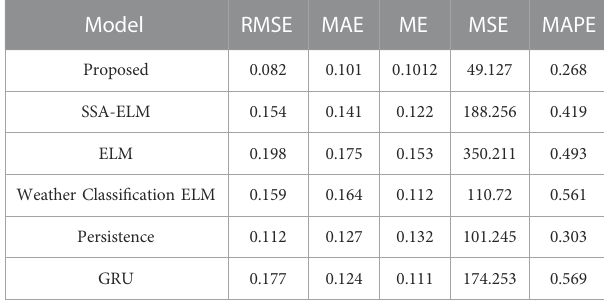
TABLE 1 Average value of each error indicator in 2021. Model